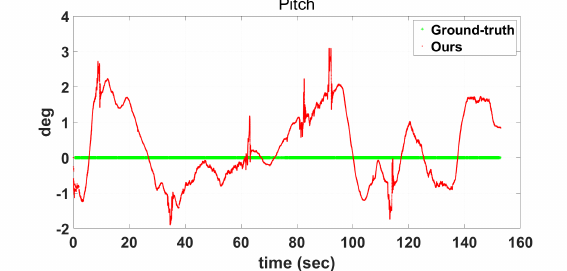
Figure 6. Comparison of our estimated pitch angle with the ground-truth for the home1 consequence.